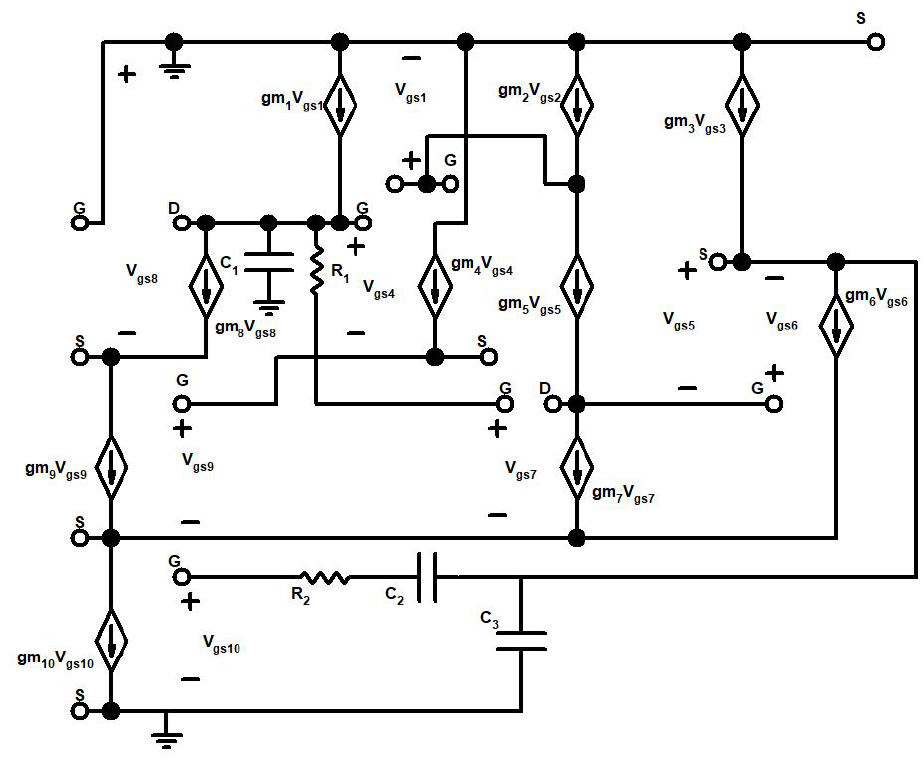
Figure 6. Small-signal analysis of the novel tunable